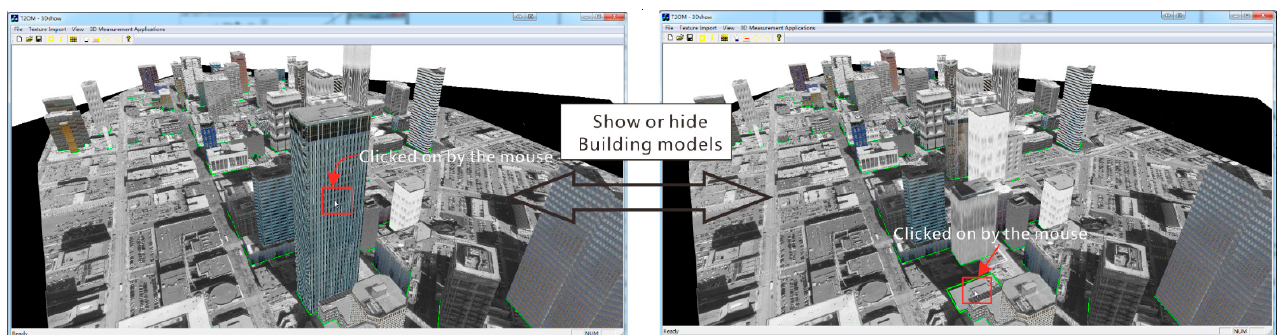
Figure 23. Selectively showing or hiding